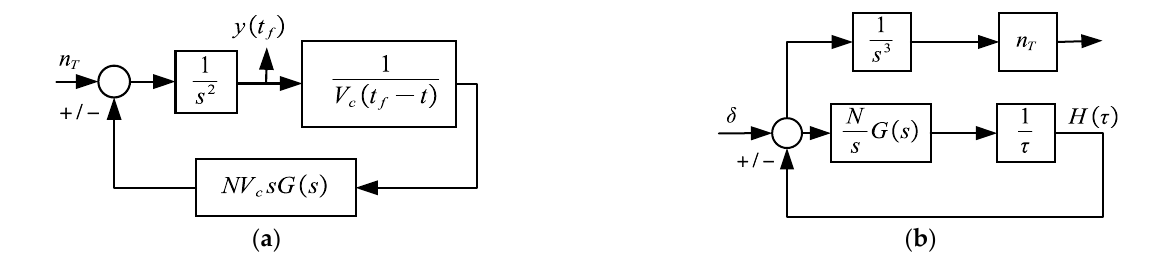
Figure 2. Block diagram of proportional navigation guidance system. ( a ) Original guidance system; ( b ) Adjoint guidance system.